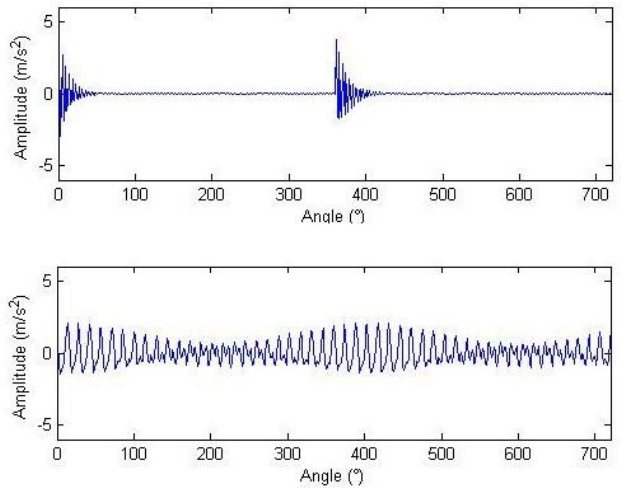
Figure 7. Impulse component (above) and component (below) with hard